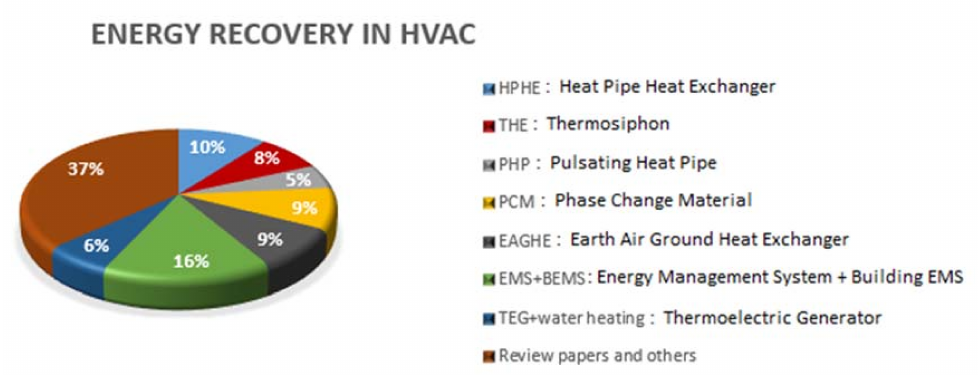
Figure 3. Investigated papers according to the topic.